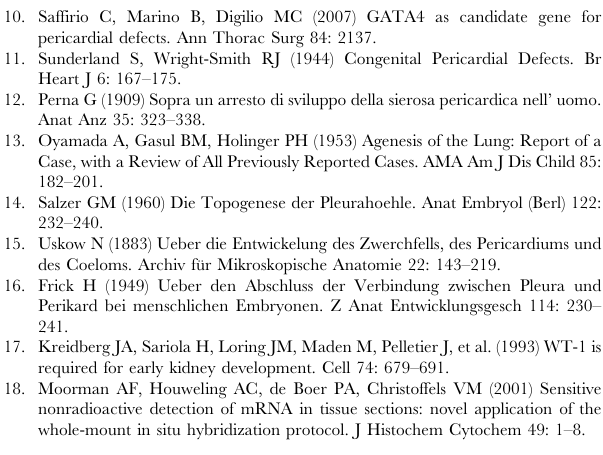
E14.5 control (upper row) and Tbx18 -deficient (lower row) hearts as indicated. Arrows highlight the remaining PPCs in Tbx18 - deficient embryos. Green arrowheads mark the sinuatrial ridges, black arrows point to the persisting PPCs in Tbx18 -deficient embryos. lu, lung; oft, outflow tract; pc, pericardial cavity; pl, pleural cavity; ppm, pleuropericardial membrane; ra, right atrium; rsh, right sinus horn; rv, right ventricle; sh, sinus horn. (TIF) Figure S2 Pericardial defects in Wt1 -deficient hearts. (A–H) Histological analysis by haematoxylin and eosin stainings on transverse sections through the PPCs of control (genotype: Wt1 + / 2 ) and Wt1 -deficient embryos from E11.5 to E14.5. (I–L) In situ hybridization analysis of Tbx18 expression on transverse sections trough the venous pole region of control and Wt1 - deficient hearts at E11.5 (I, J) and E12.5 (K, L). Stages and genotypes are as indicated. Green arrowheads point to the sinuatrial ridges in both control and Wt1 -deficient embryos. Black arrows highlight the PPM defects in Wt1 -deficient embryos at